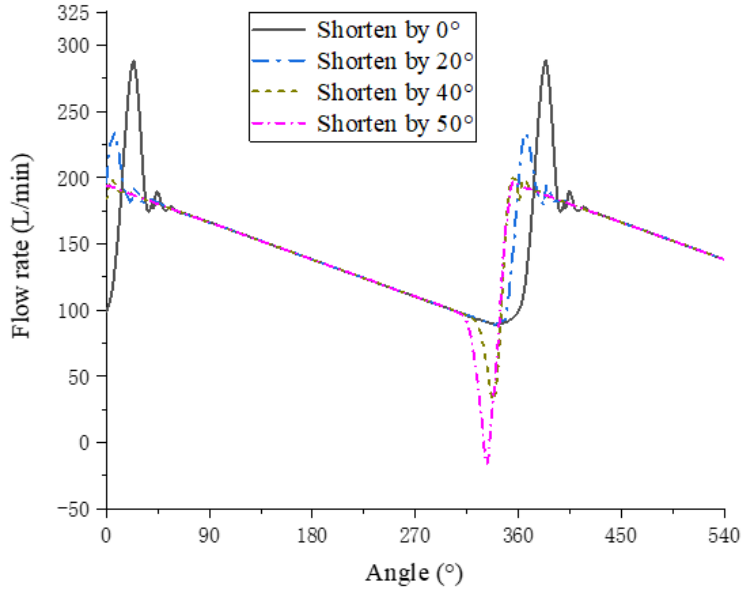
Figure 20. Outlet flow at different line lengths.